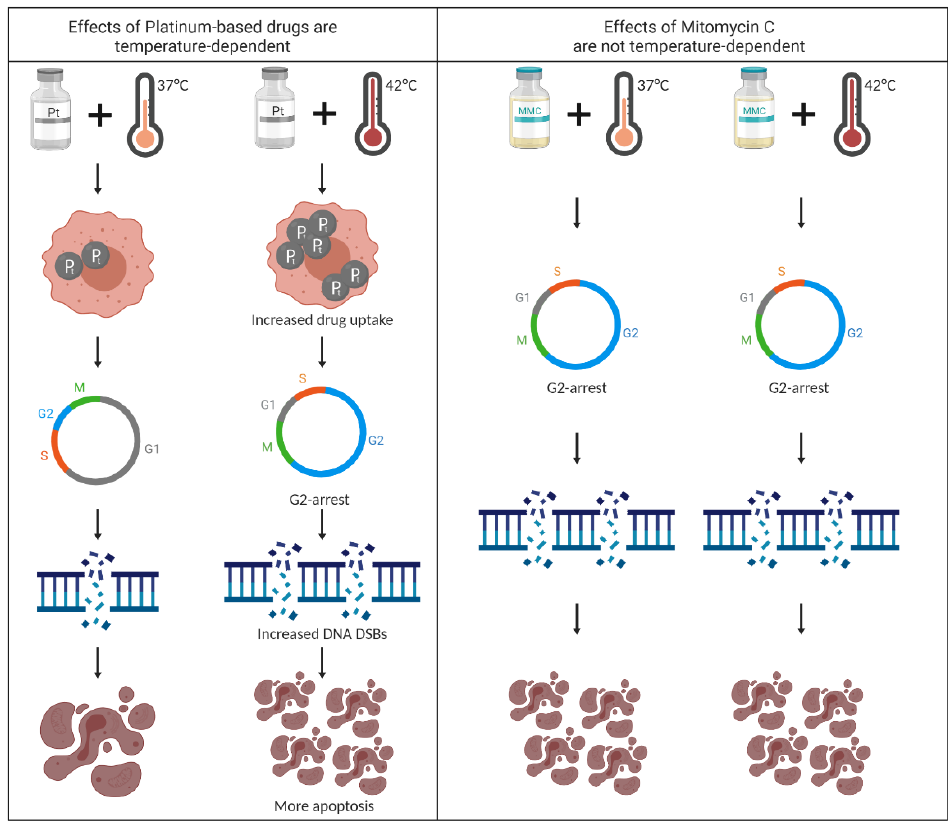
Figure 6. Graphical conclusion. ( A ) Platinum-based drugs require hyperthermia to induce significantly more DNA double strand breaks (DSBs), G2 cell cycle arrest, and increased apoptosis in colorectal cancer cells. ( B ) MMC treatment, even without hyperthermia, induces DNA DSBs, results in G2-arrest and leads to high apoptotic levels in colorectal cancer cells. Created with Biorender.com.